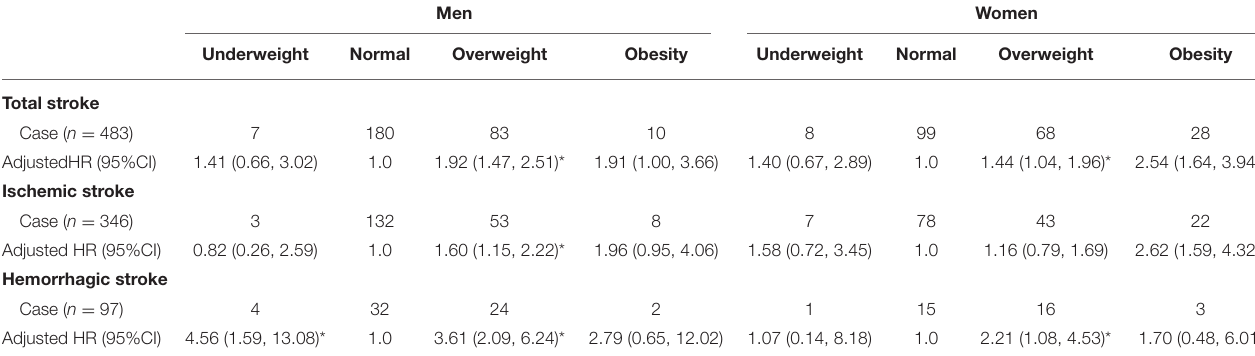
TABLE 5 | Association of BMI with total, ischemic, and hemorrhagic stroke using Cox regression analysis among population aged < 65 years. Men Women Underweight Normal Overweight Obesity Underweight Normal Overweight